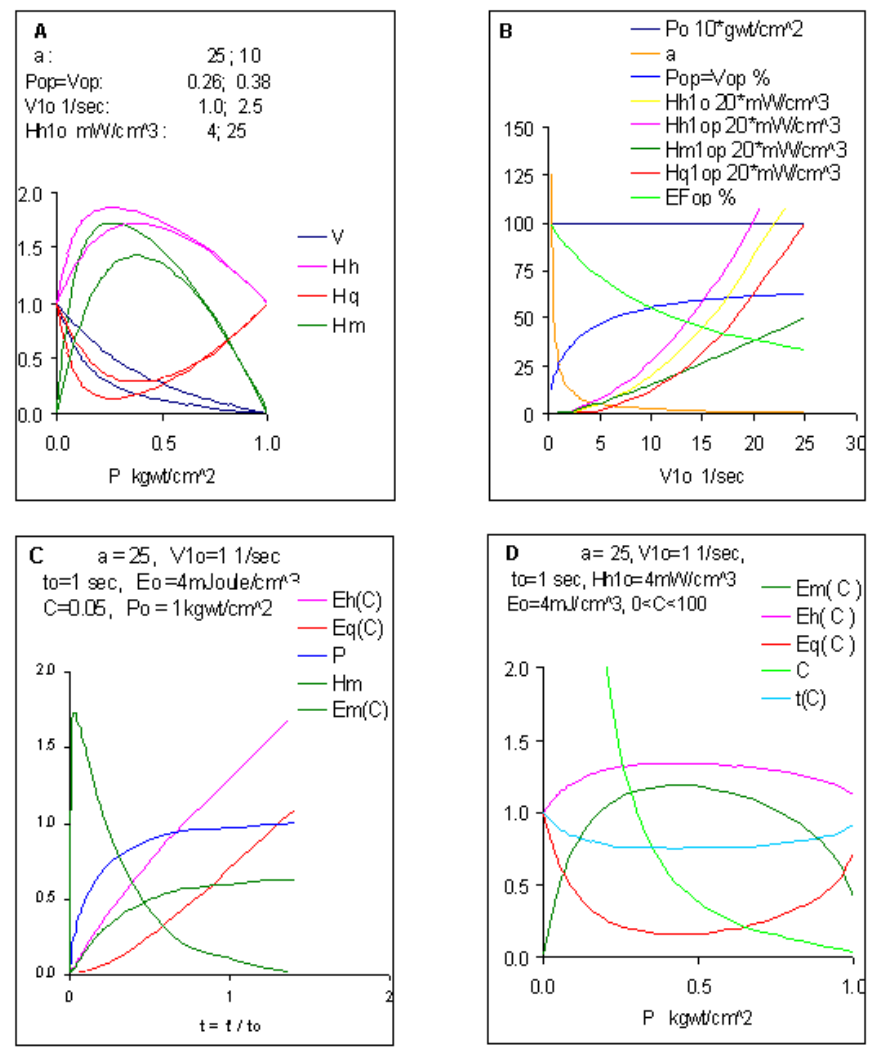
Figure 3. Force-Velocity and Power-Balance relations in isotonic and isometric contractions (see also Supplementary Box 3).